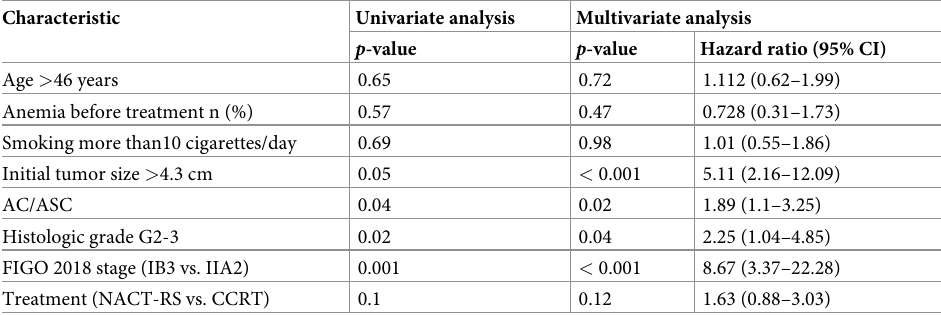
AC/ASC, Adenocarcinoma or adenosquamous carcinoma; FIGO, International Federation of Gynecology and Obstetrics; NACT-RS, neoadjuvant chemotherapy followed by radical surgery; CCRT, concomitant chemotherapy and